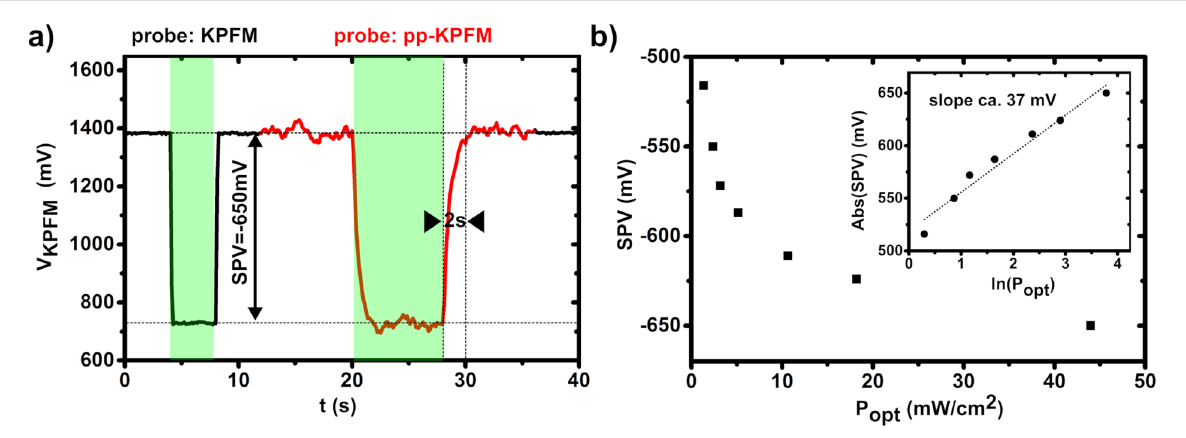
Figure 5: (a) Plot of the KPFM compensation potential measured at the solar cell cathode as a function of time (spectroscopic sequence of 320 pixels, 125 ms per pixel). The probe signal configuration is automatically switched from standard KPFM to pp-KPFM (pulses of 250 µs, repetition frequency of 200 Hz) at t = 12 s and set back to standard KPFM at t = 36 s. The illumination state is switched twice from dark to cw illumination. First illumination sequence: 4 s < t < 8 s, second sequence: 20 s < t < 28 s, P opt = 48 mW ∙ cm − 2 at 515 nm). (b) Plot of the surface photovoltage (SPV) as a function of the optical power P opt . The SPV is calculated as the difference between the KPFM potential values measured (standard KPFM configura- tion) at cw illumination and in the dark. Inset: plot of the SPV (in absolute value) as a function of the natural logarithm of the optical